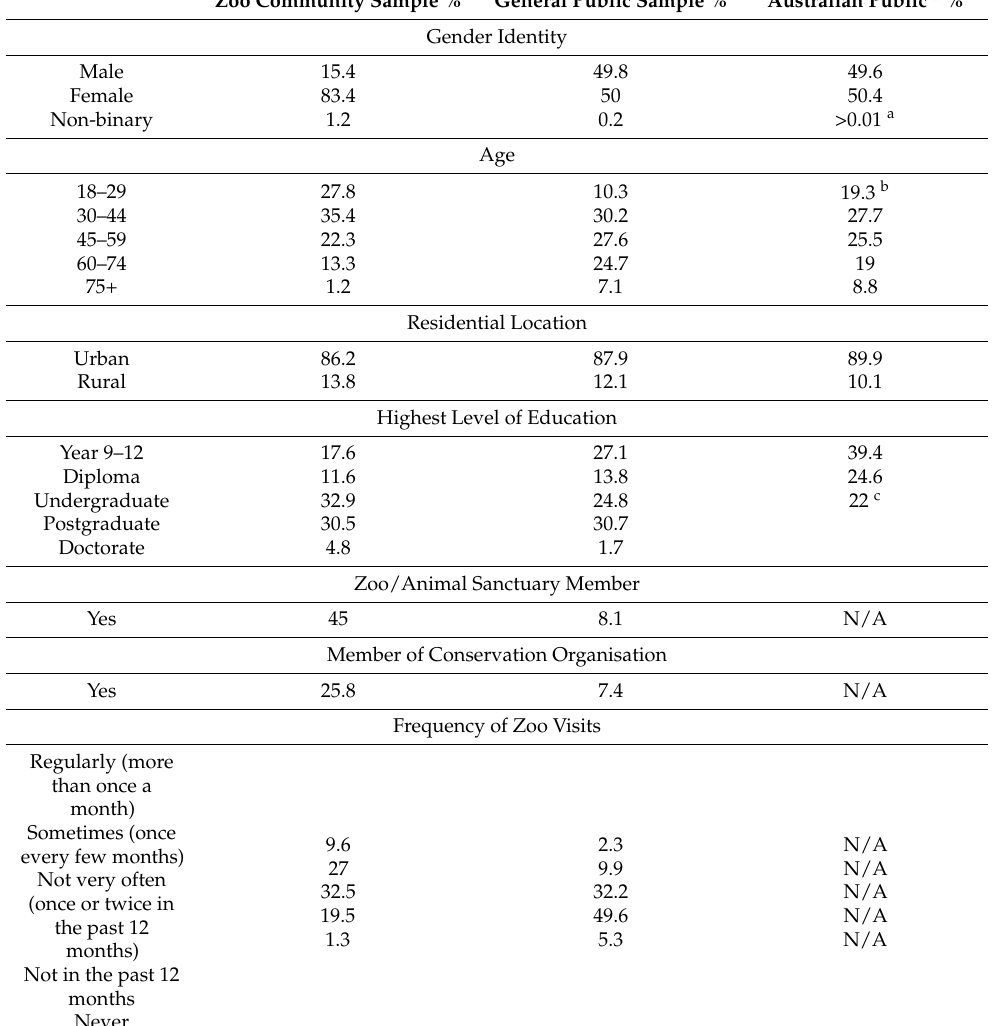
Table 2. Sample demographic characteristics compared with the Australian